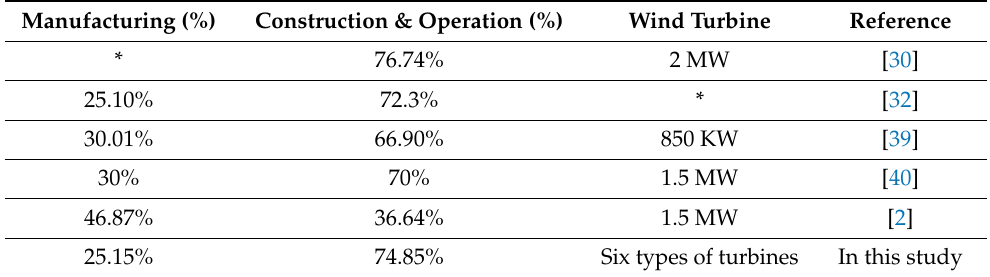
Table 4. Comparison with other research results.